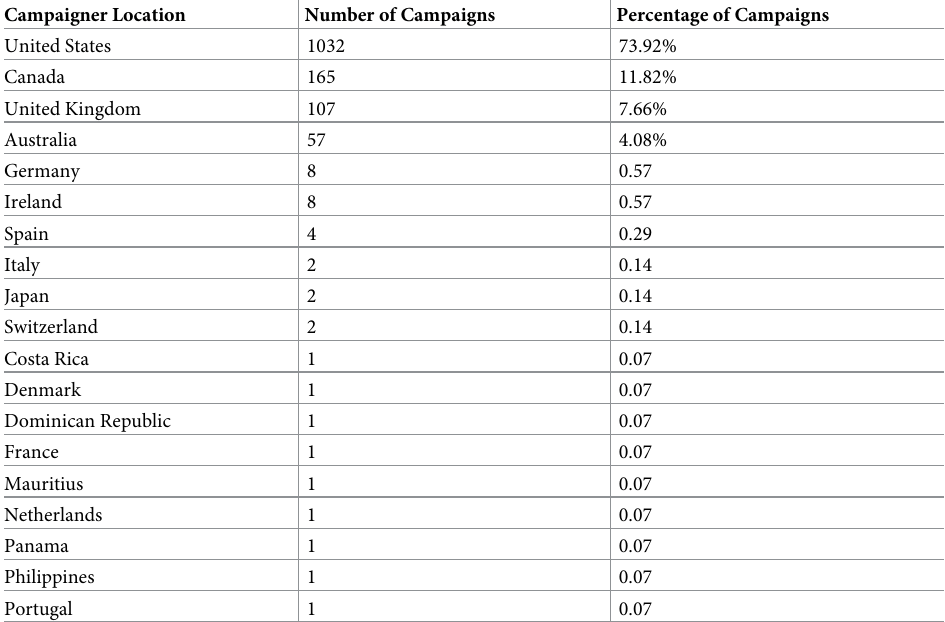
Table 1. Campaigner locations.